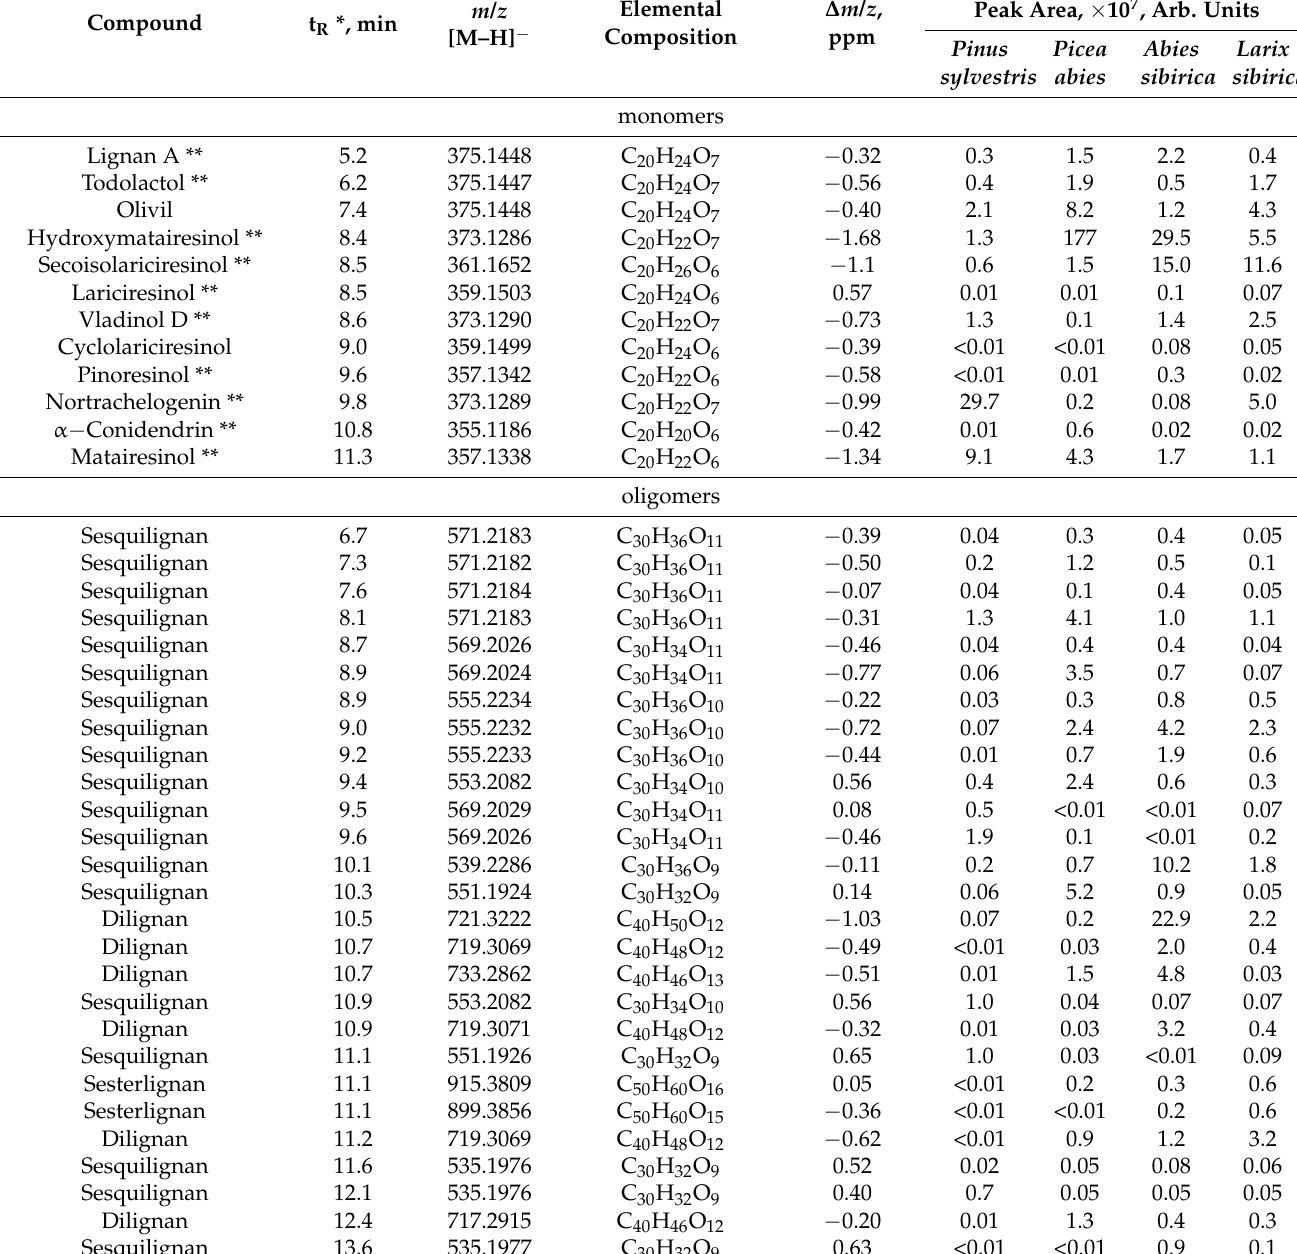
Table 4. Lignans detected in coniferous knotwood extracts by